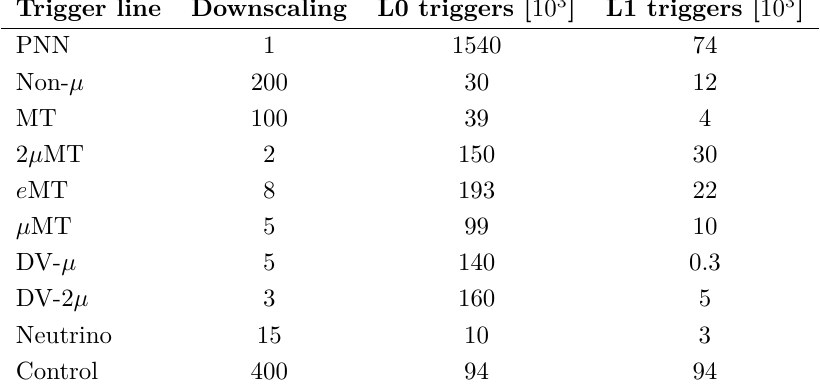
Table 4. List of K + trigger lines, L0 downscaling factors, and numbers of L0 triggers after downscaling and L1 triggers produced per spill at a beam intensity of 1 . 2 × 10 9 Argonion counts. No L1 conditions are applied to the control trigger line.